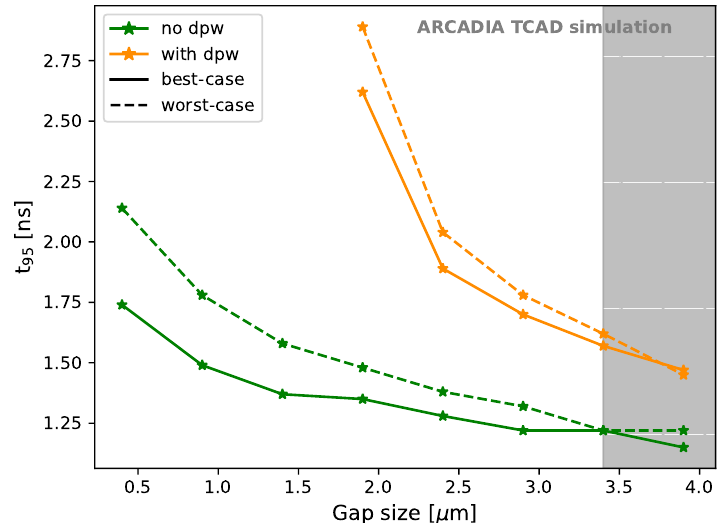
Figure 21. t 95 as a function of the gap size for best-case and worst-case scenarios. Microstrips with large gaps, and hence small (deep) p-wells, are to be preferred